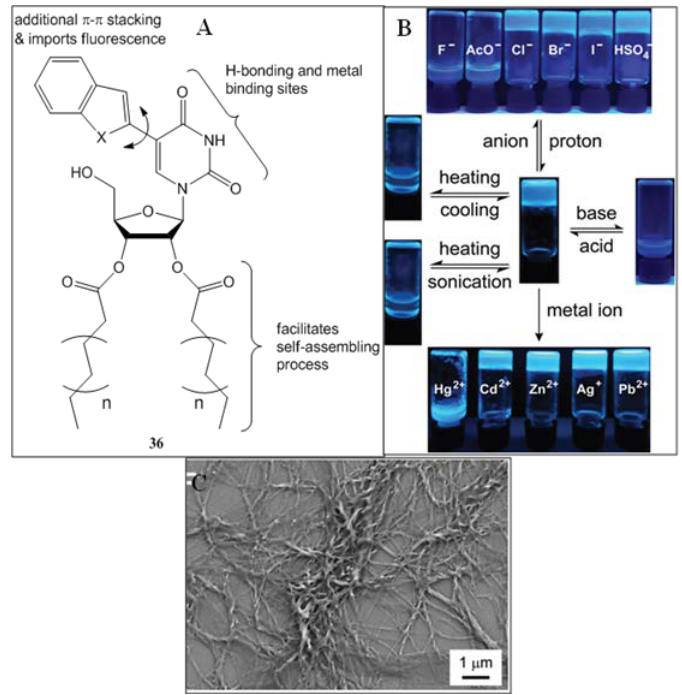
Figure 24. ( A ) Structures of uracil derived glycolipids; ( B ) responsiveness of benzothiophene-modified nucleolipid gel 36 (with a palmitoyl alkyl chain) to physical (temperature and sonication) and chemical stimuli (anion, acid-base, and metal ion). Photographs under UV illumination (365 nm) clearly show the changes in fluorescence upon application of external stimuli; ( C ) field emission scanning electron microscopy (FESEM) images of its xerogels forming twisted fibers. Reprinted with permission from [103]. Copyright 2016 Royal Society of Chemistry.